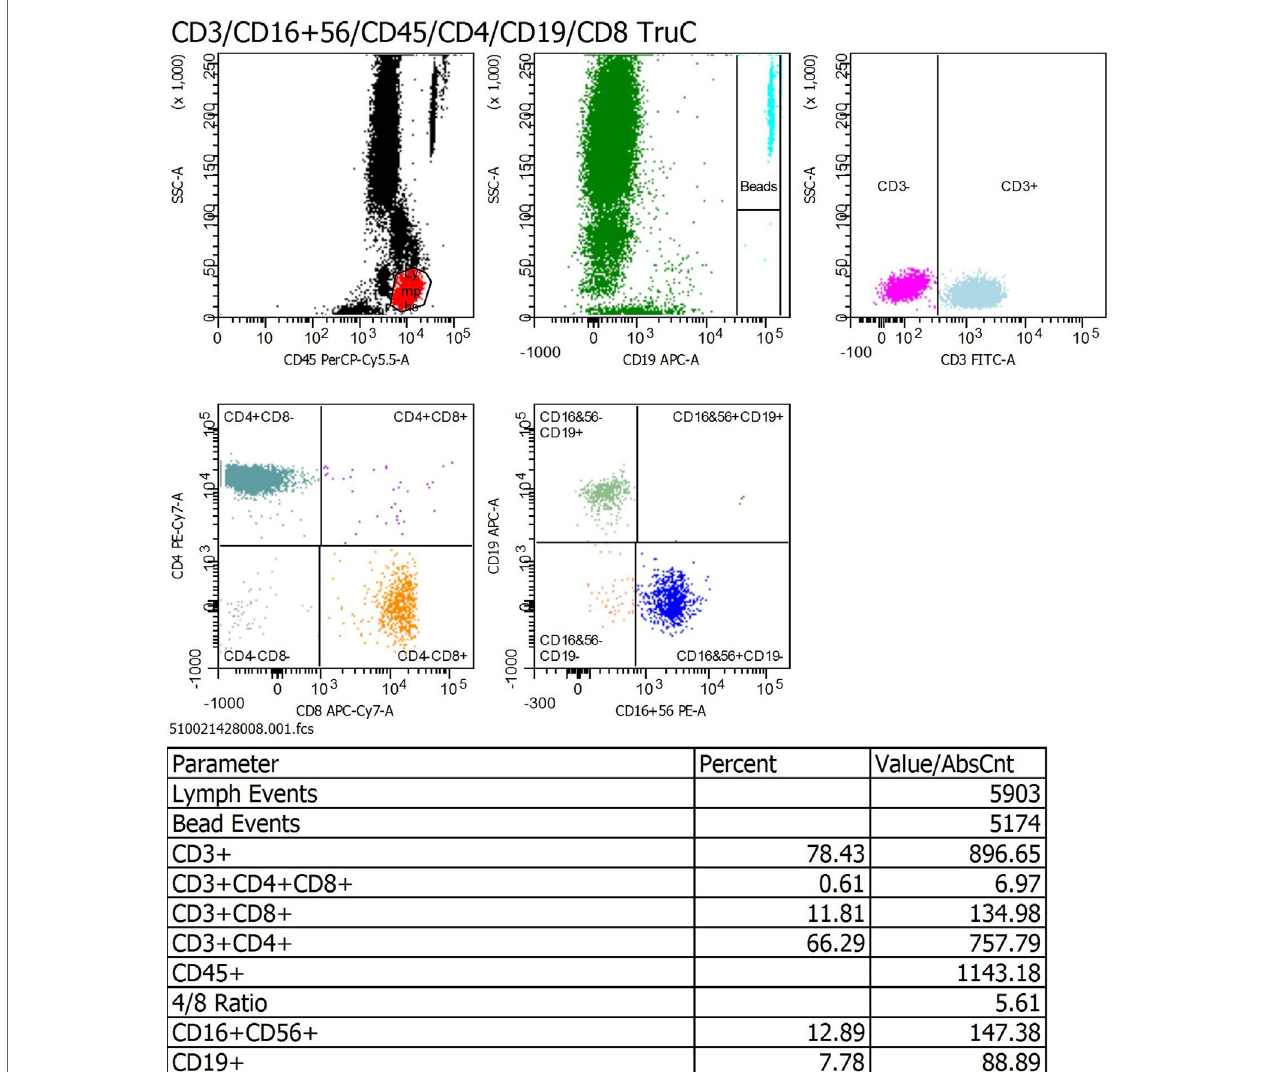
FigUre 2 | Representative schema of a peripheral blood lymphocyte populations FACS profile in a hemodialysis